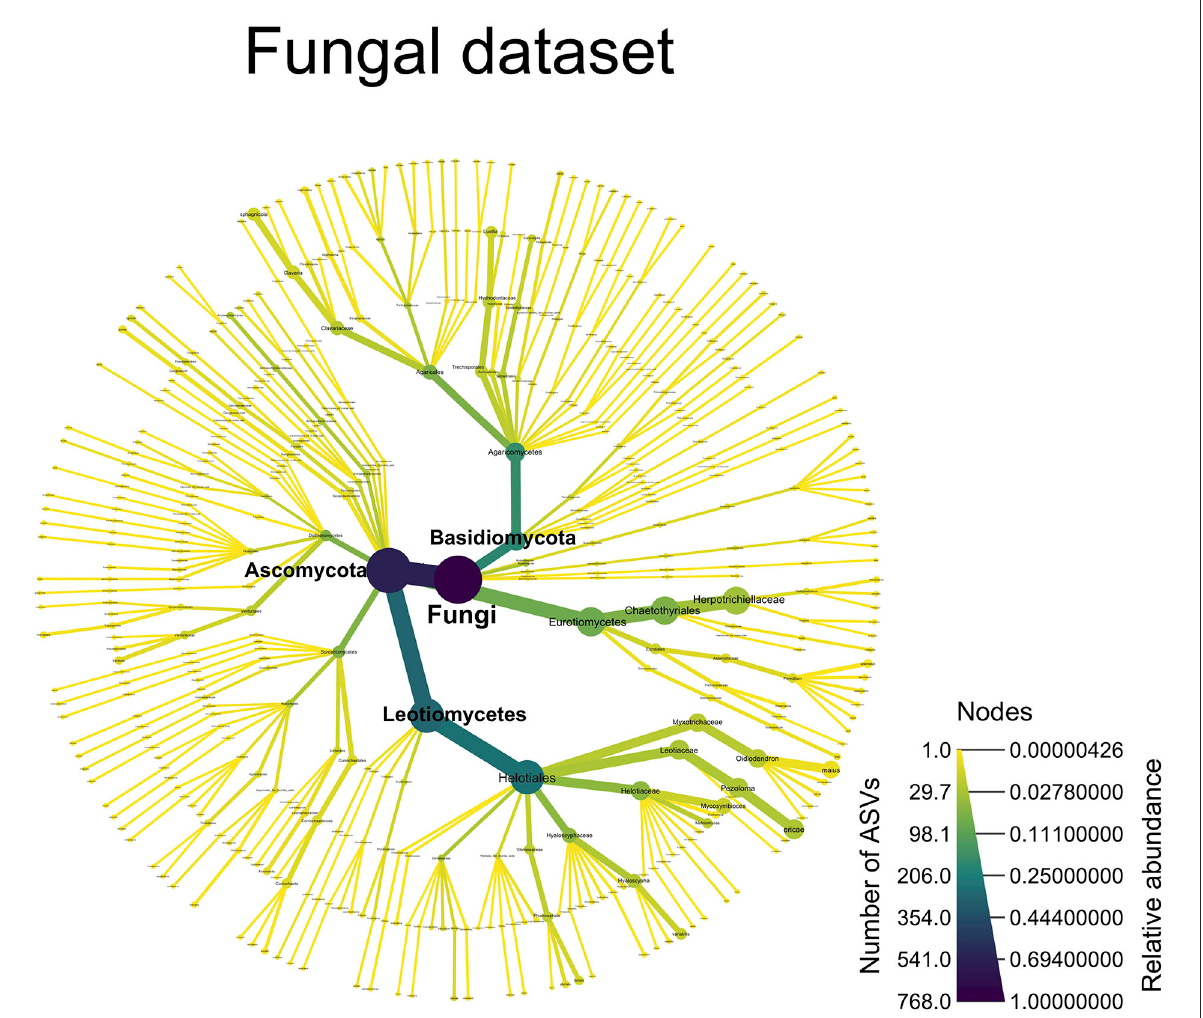
FIGURE5 A taxonomy overview of the fungal community. This figure displays all of the fungal ASVs, which were assigned to a taxonomic level [ASVs not assigned at a particular taxonomic level (NAs) are not shown]. The color of the edges and nodes indicates the number of ASVs found at a given taxonomic level, with darker color indicating more ASVs and lighter colors indicating fewer ASVs. The size of the edges and nodes indicates the relative abundance of the ASVs assigned to a particular taxonomic level with wider edges/nodes, indicating a high relative abundance and narrower edges/nodes, indicating a low relative